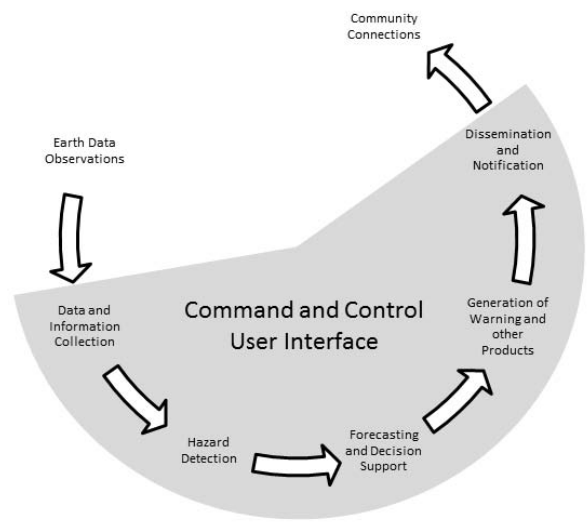
Fig. 1. Key Operational Components of an EWS for tsunami (USIOTWS, 2007) with CCUI.